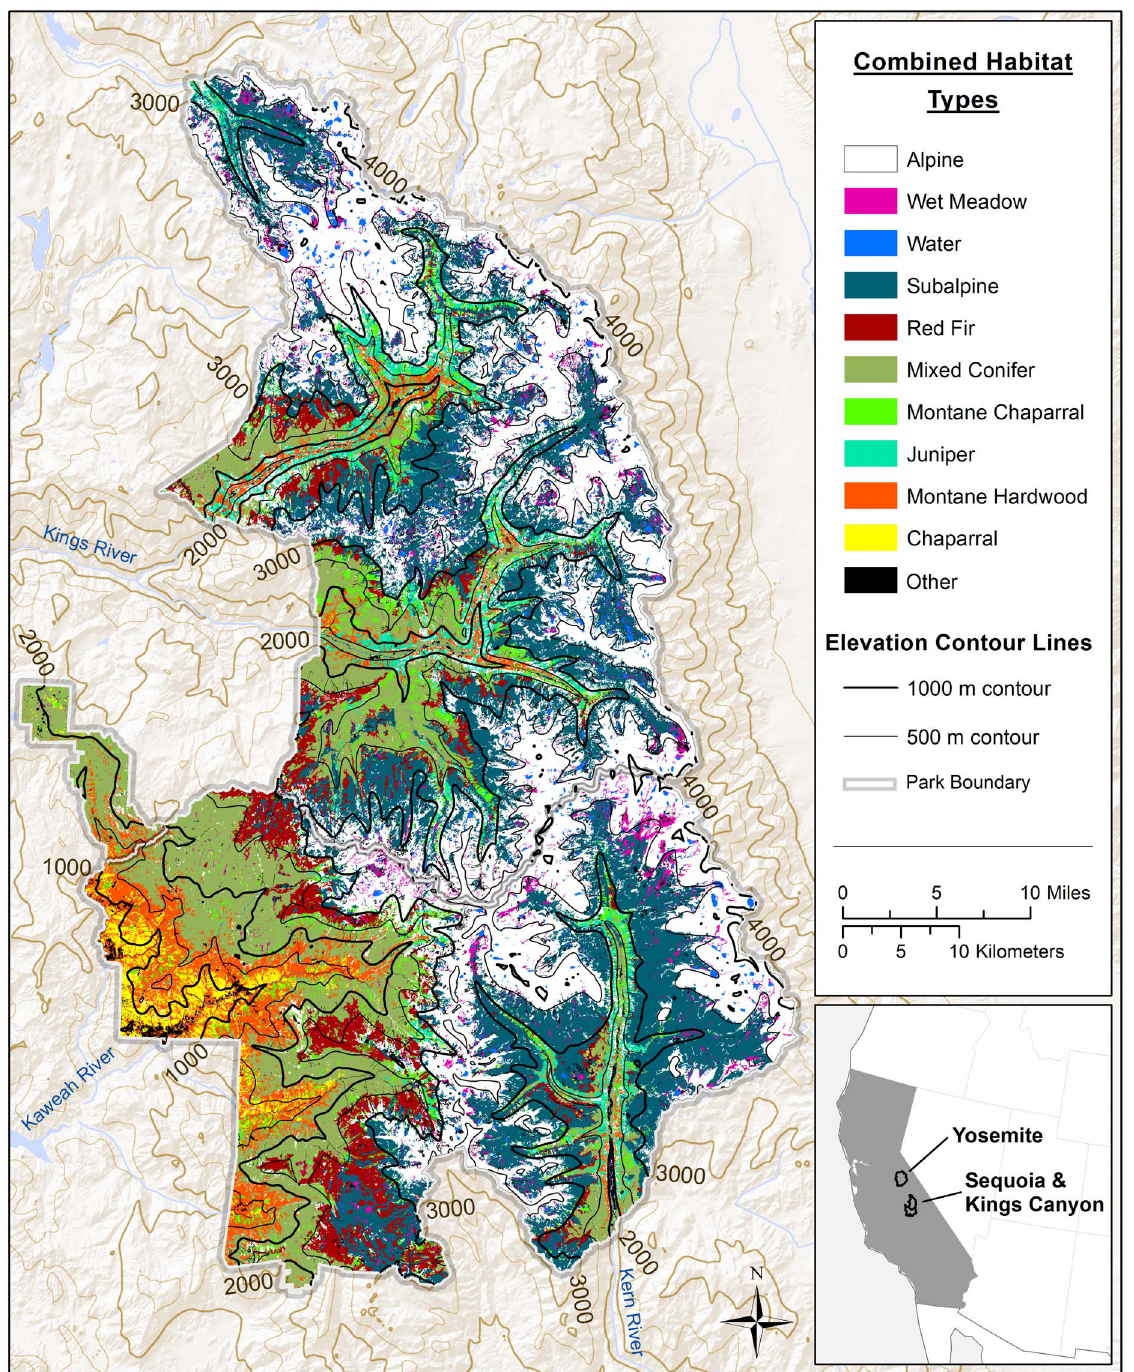
Figure 1. The spatial distribution of combined California wildlife habitat types within Sequoia Kings Canyon National Parks. The 26 California wildlife habitat types found within Sequoia Kings Canyon National Parks were merged into 11 ‘‘combined’’ habitat types to make elevation and vegetation patterns more comprehensible to the